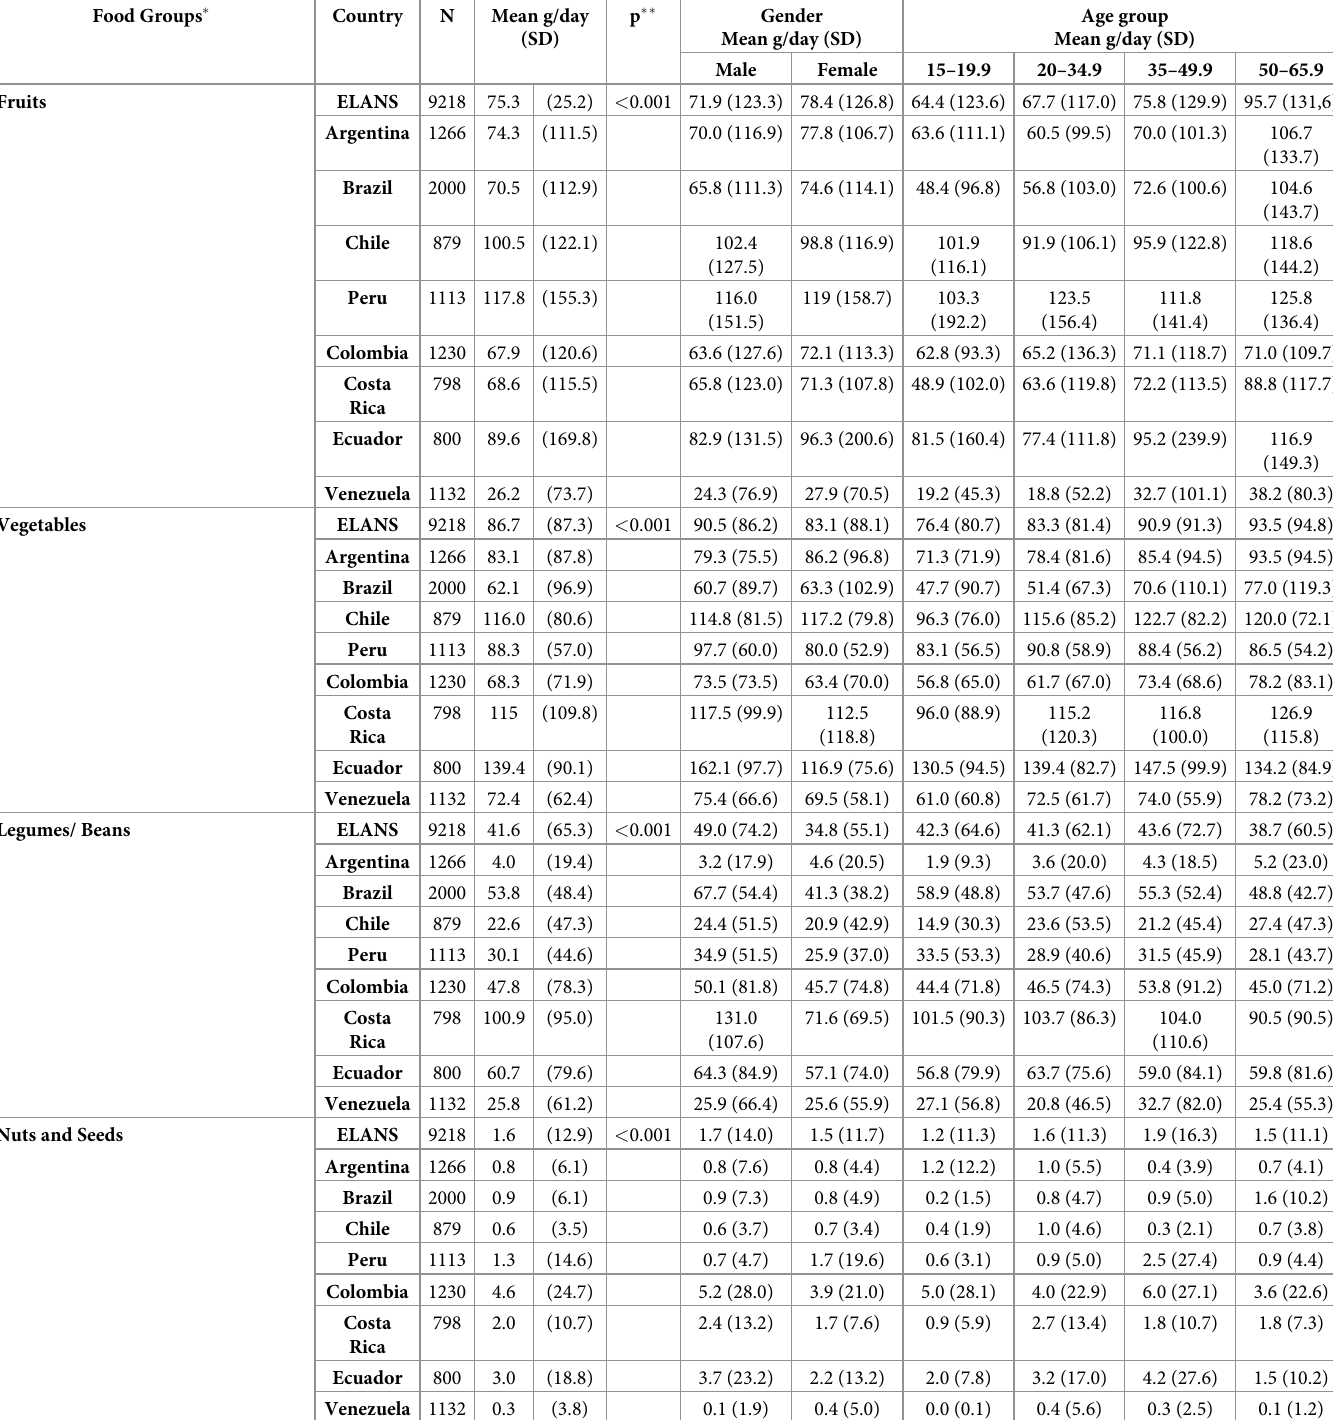
Table 3. Comparison of dietary intake of the ten major food groups in individuals residing in urban areas of Latin America, according to the country of living, gen- der and age. Food Groups